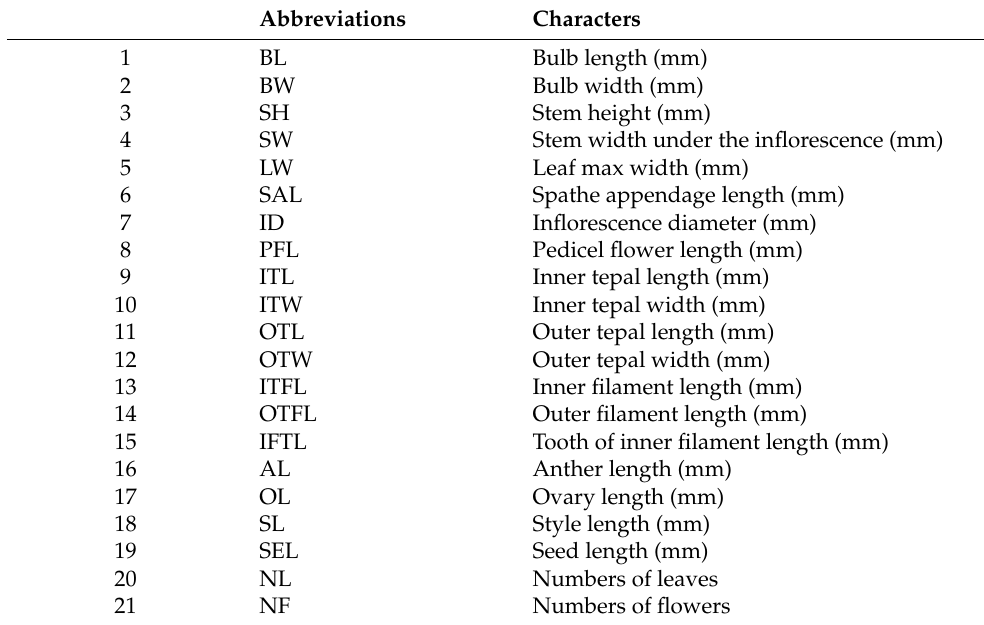
Table 1. Morphological characters employed in the morphometric